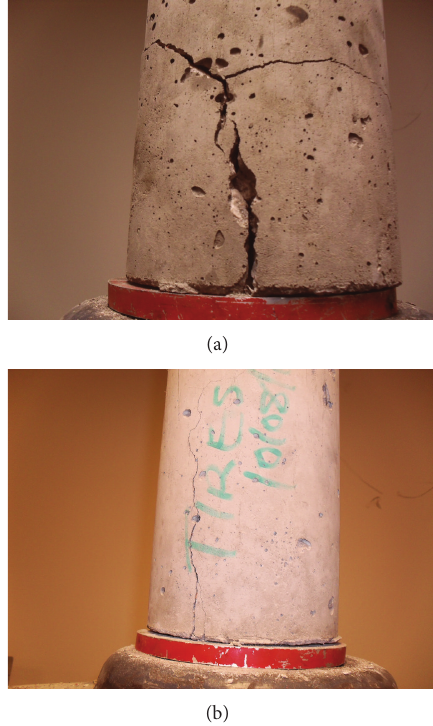
Figure 11: (a) Failure pattern for Control-0% TDA concrete, (b) 7.5% TDA-1 󸀠󸀠 concrete failure pattern during pull-out test. Wide and multiple cracks are noted in the Control-0% TDA concrete while a single crack forms in 7.5% TDA-1 󸀠󸀠